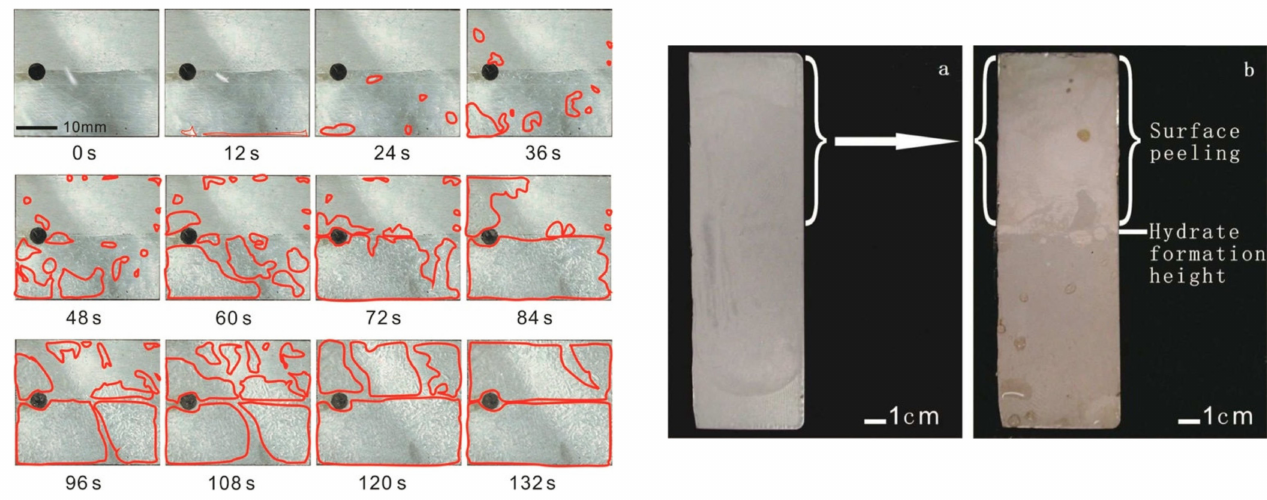
Figure 4. ( Left ) Images depicting THF hydrate growth on coated surfaces over a period of time. ( Right ) The red areas depict the zones where hydrates formed. Changes observed in a coated substrate ( a ) before and ( b ) after the high-pressure methane hydrate formation experiments in an autoclave. Reprinted with permission from ref. [52]. © 2021 American Chemical